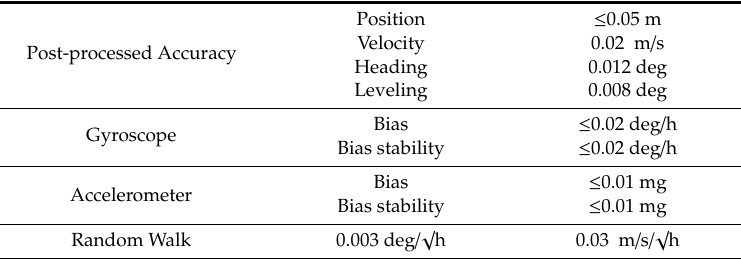
Figure 12. Equipment for test #2. Table 7. POS620 reference system performance parameters.